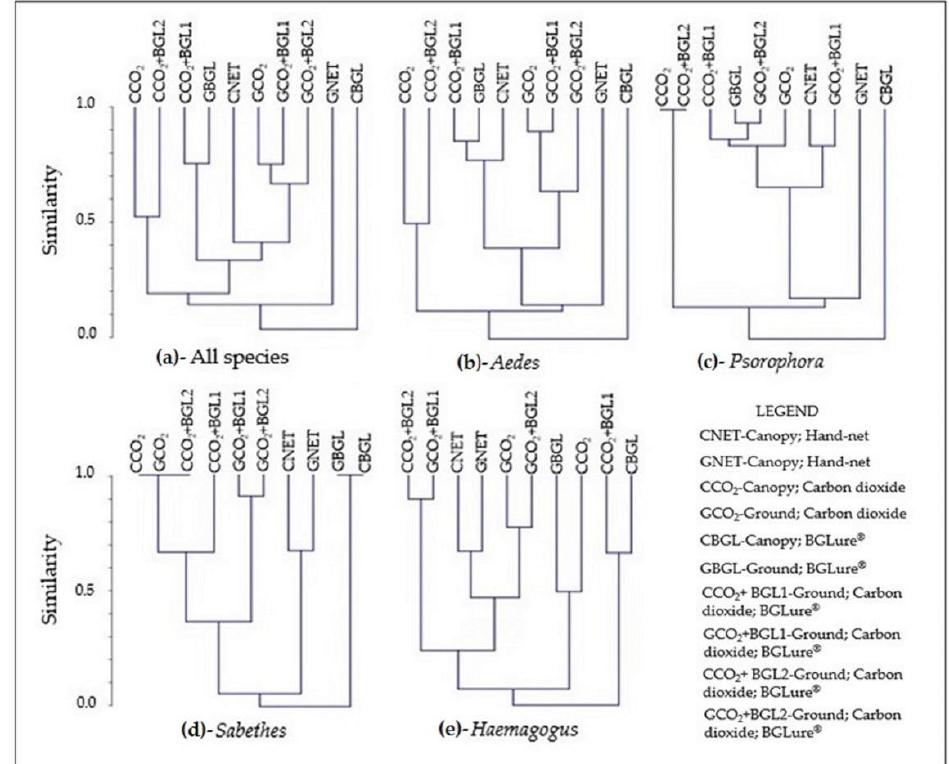
Figure 3. Bray–Curtis similarity dendrogram for different methods (technique–attractant–stratum) for the collection of Culicidae specimens in the “Pé -do- Gigante” sector of the Vassununga State Park, according to all identified species ( a ) and, according to the four genera with the highest number of specimens: ( b ) — Aedes ; ( c ) — Psorophora ; ( d ) — Sabethes ; ( e ) — Haemagogus .